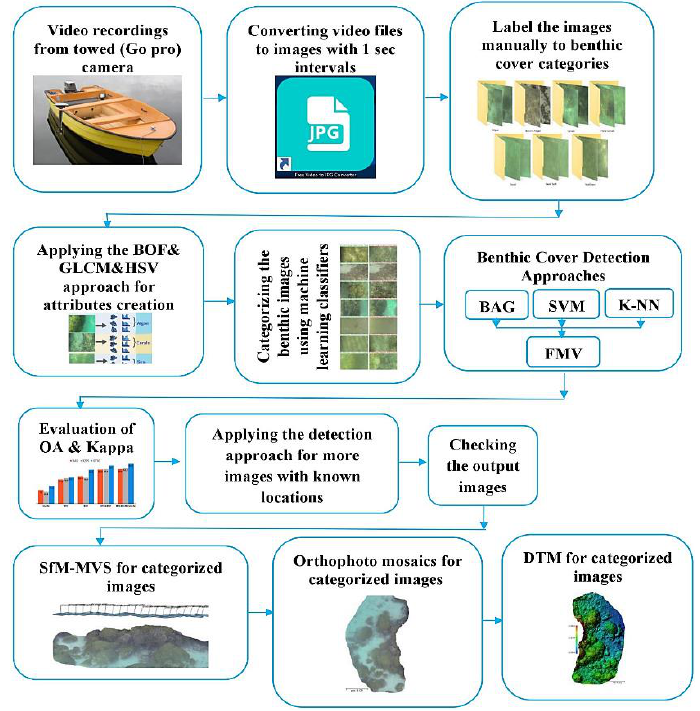
Figure 4. The workflow of the proposed benthic cover classification and 3D mapping.